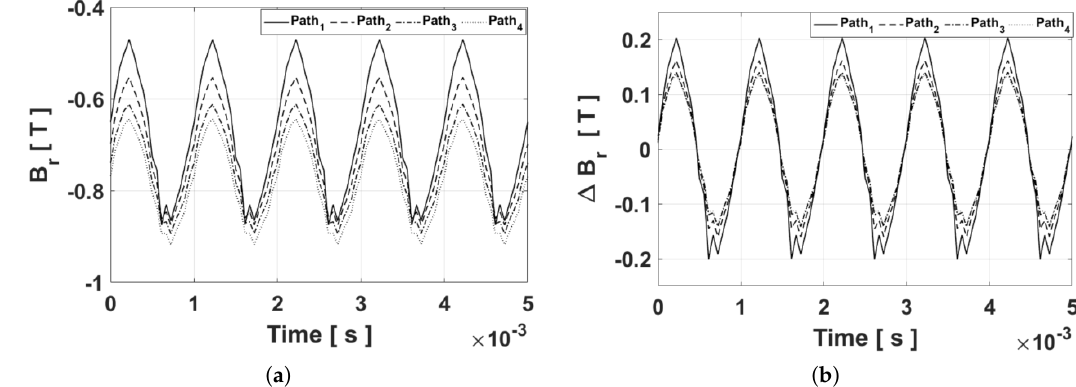
Figure 18. Evolution of the radial component of B in the middle of the North PM according to the time for different tangential path: ( a ) with and ( b ) without the average